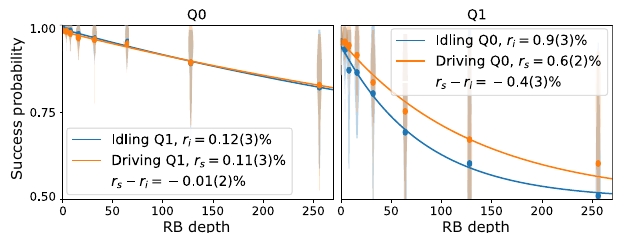
FIG. 4. Simultaneous direct randomized benchmarking on the QSCOUT platform. We run simultaneous DRB experiments (see the caption to Fig. 2) on a two-qubit QSCOUT processor. No crosstalk compensation is used in this experiment. Q0 performs well independent of context (i.e., whether Q1 is driven). In con- trast, Q1 performs at least 5 times worse in both contexts, and its error per gate appears to depend on whether Q0 is driven. Oddly, however, driving Q0 actually reduces Q1’s error rate, suggesting a negative rate of crosstalk-induced errors. We identify the par- ticular calibration protocol used as the probable cause (see the main